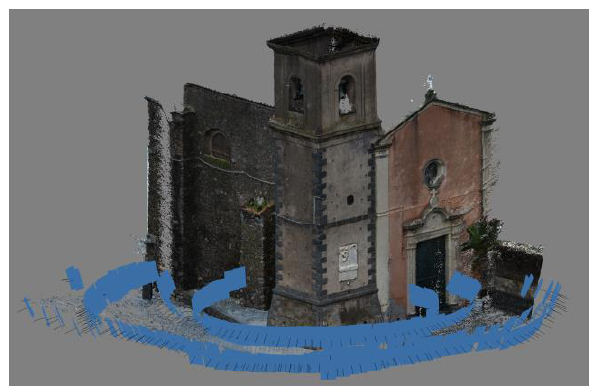
Figure 4. The point cloud obtained with a SfM photogrammetric